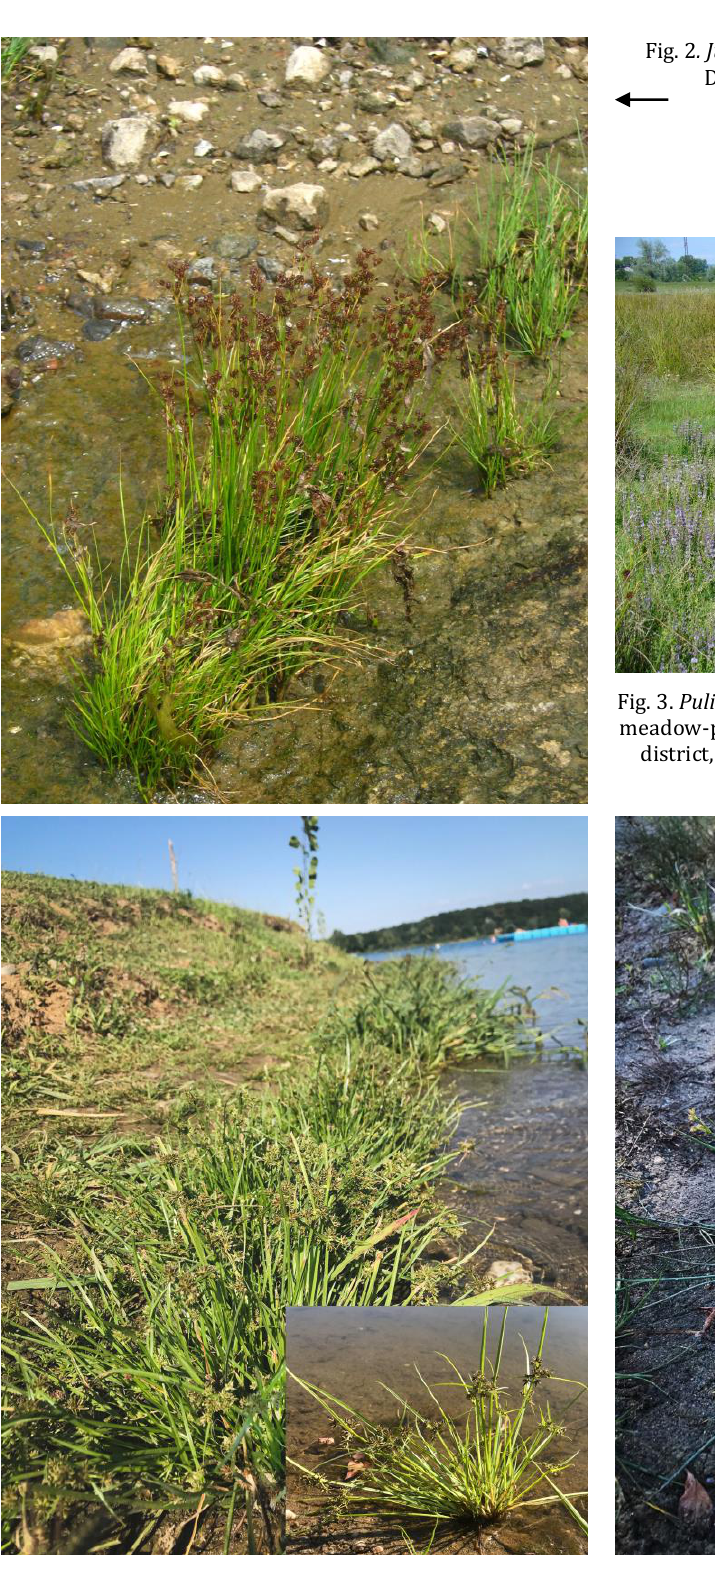
Fig. 4. The phytocoenoses with the dominance of Cyperus fuscus on the periphery of the reservoir (near the village of Dyidovo, Beregiv district, Zakarpattia region, 12.08.2020) (Photo by L. Felbaba-Klushyna)